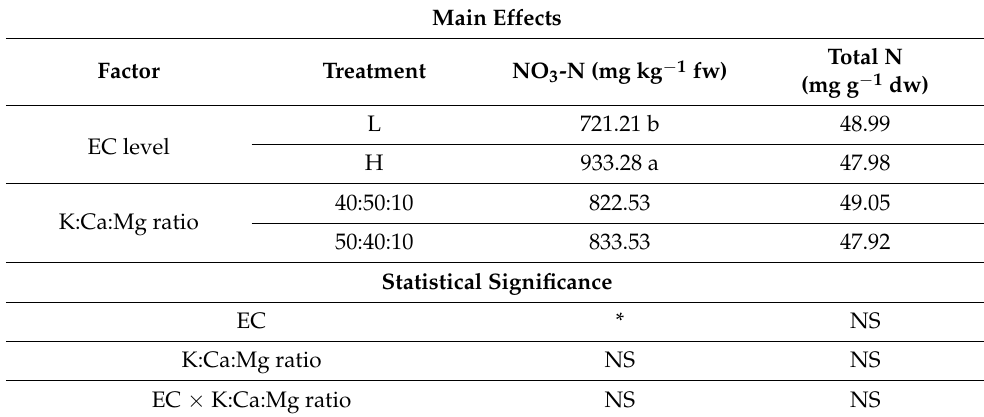
Table 5. Impact of different EC levels (low and high, as L and H, respectively) and K:Ca:Mg ratios (40:50:10 and 50:40:10) on the concentration of nitrates in fresh tissues and total nitrogen in dry tissues of hydroponically grown spiny